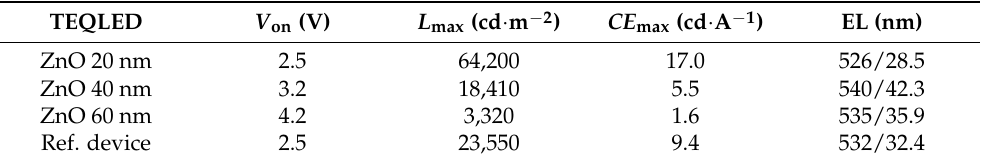
Table 2. Tuning of the optical length of cavity resonance by ZnO thickness for TEQLEDs. The reference device was a BEQLED without optimized structure.